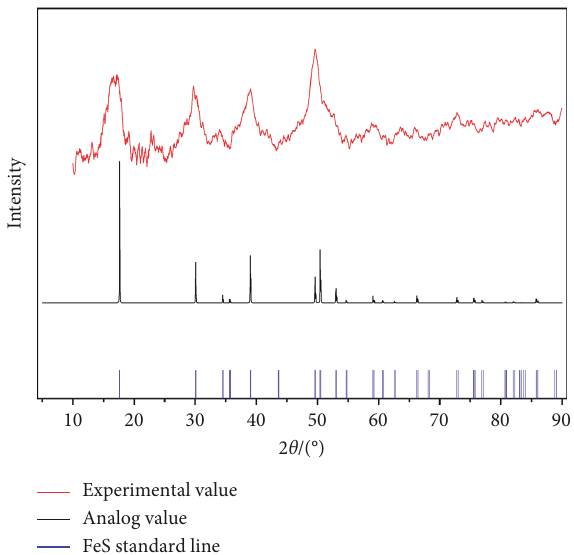
Figure 1: Comparison of the experimental X-ray diffraction pattern of active iron sulfide compounds sample with simulated X- ray diffraction pattern of FeS crystal model.